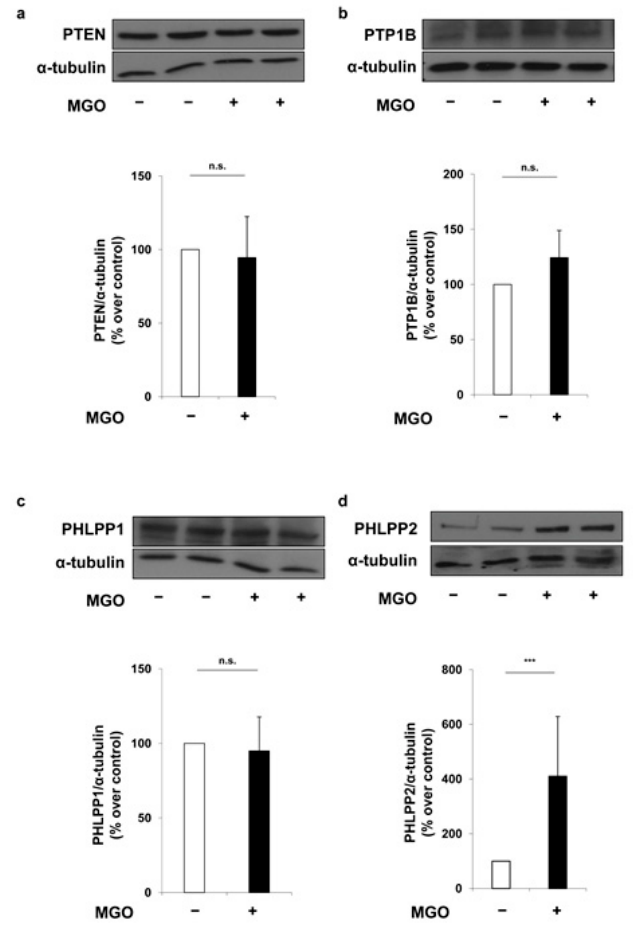
Figure 1. Effect of methylglyoxal (MGO) on miR-214 and miR-126 target phosphatases of insulin signaling mediators. Mouse aortic endothelial cells (MAECs) were treated with 500 µ mol/L MGO for 16 h. Protein lysates obtained from these cells were analyzed by Western blot with anti-PTEN ( a ) anti-PTP1B ( b ) anti-PHLPP1 ( c ) and anti-PHLPP2 antibodies ( d ). Protein normalization was performed using α -tubulin antibody. Exposure timing was of 1 min for blots in panels ( a , c , d ), and 2 min for blots in panel ( b ). Protein levels were quantified by the densitometric analysis of at least three independent experiments. Bars in the graphs represent the mean ± SD of the percent (%) over control ( − MGO). Statistical analysis was evaluated using the Student’s t -test; *** p ≤